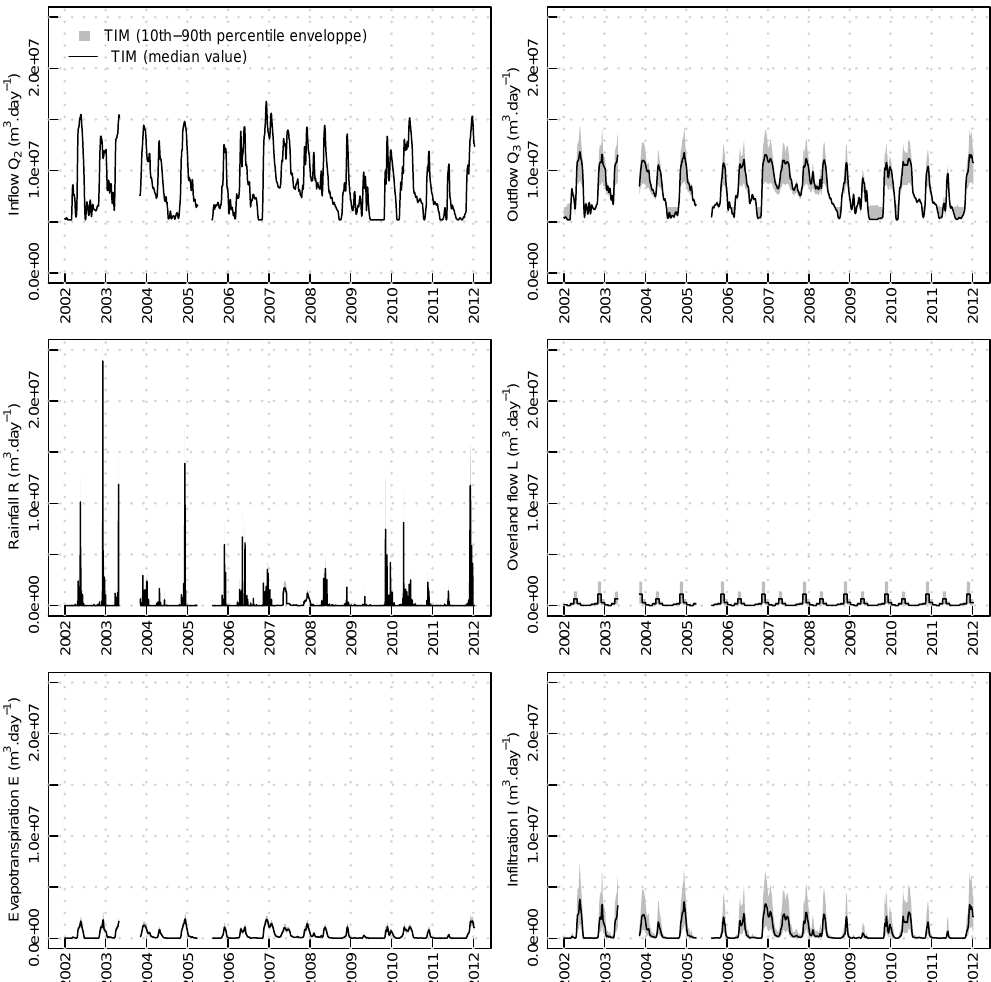
Fig. 10. Simulated total daily discharges Q 2 , Q 3 , rainfall R , overland flow L , evapotranspiration E , and infiltration I for 2002–2011, as computed by